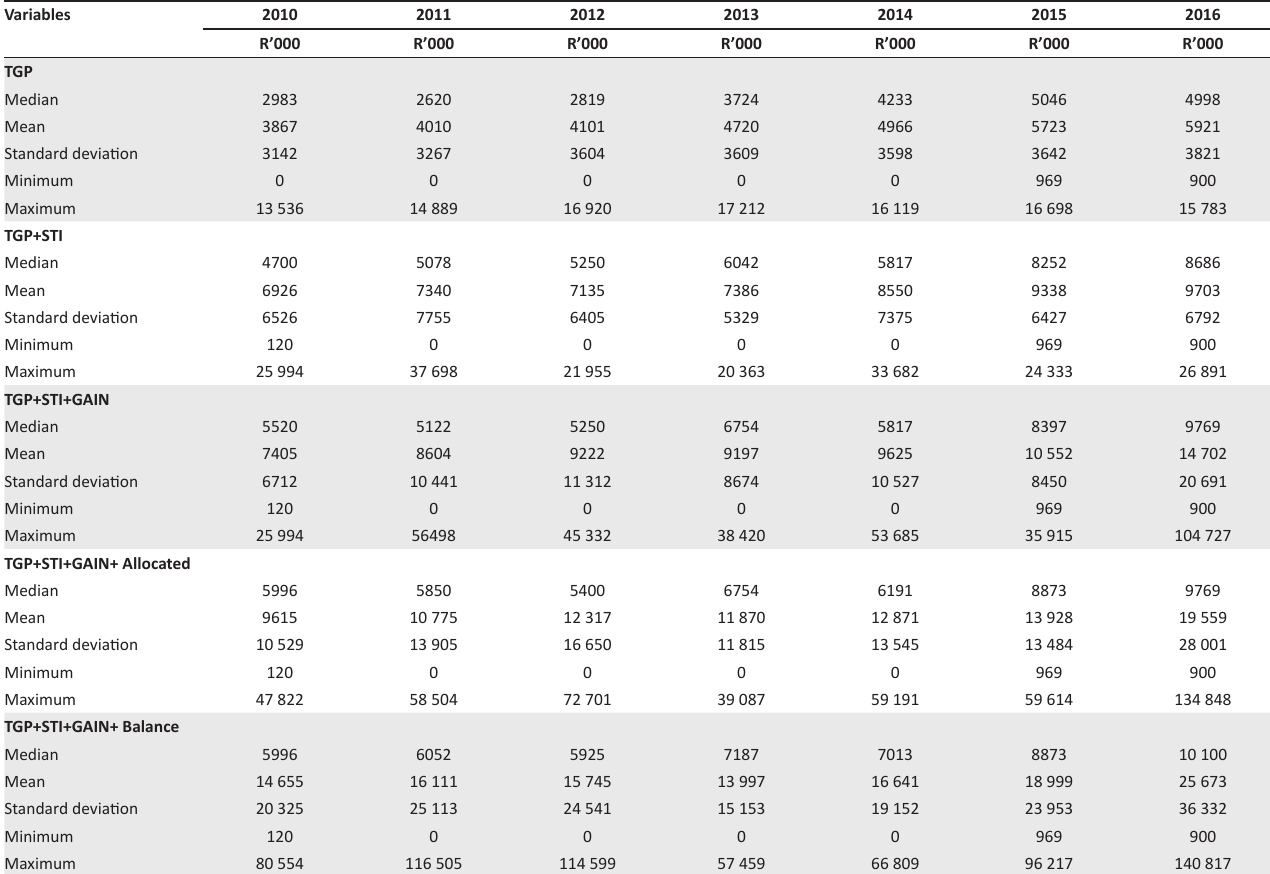
TABLE 2-A1: Descriptive statistics on chief executive officer’s remuneration categories.